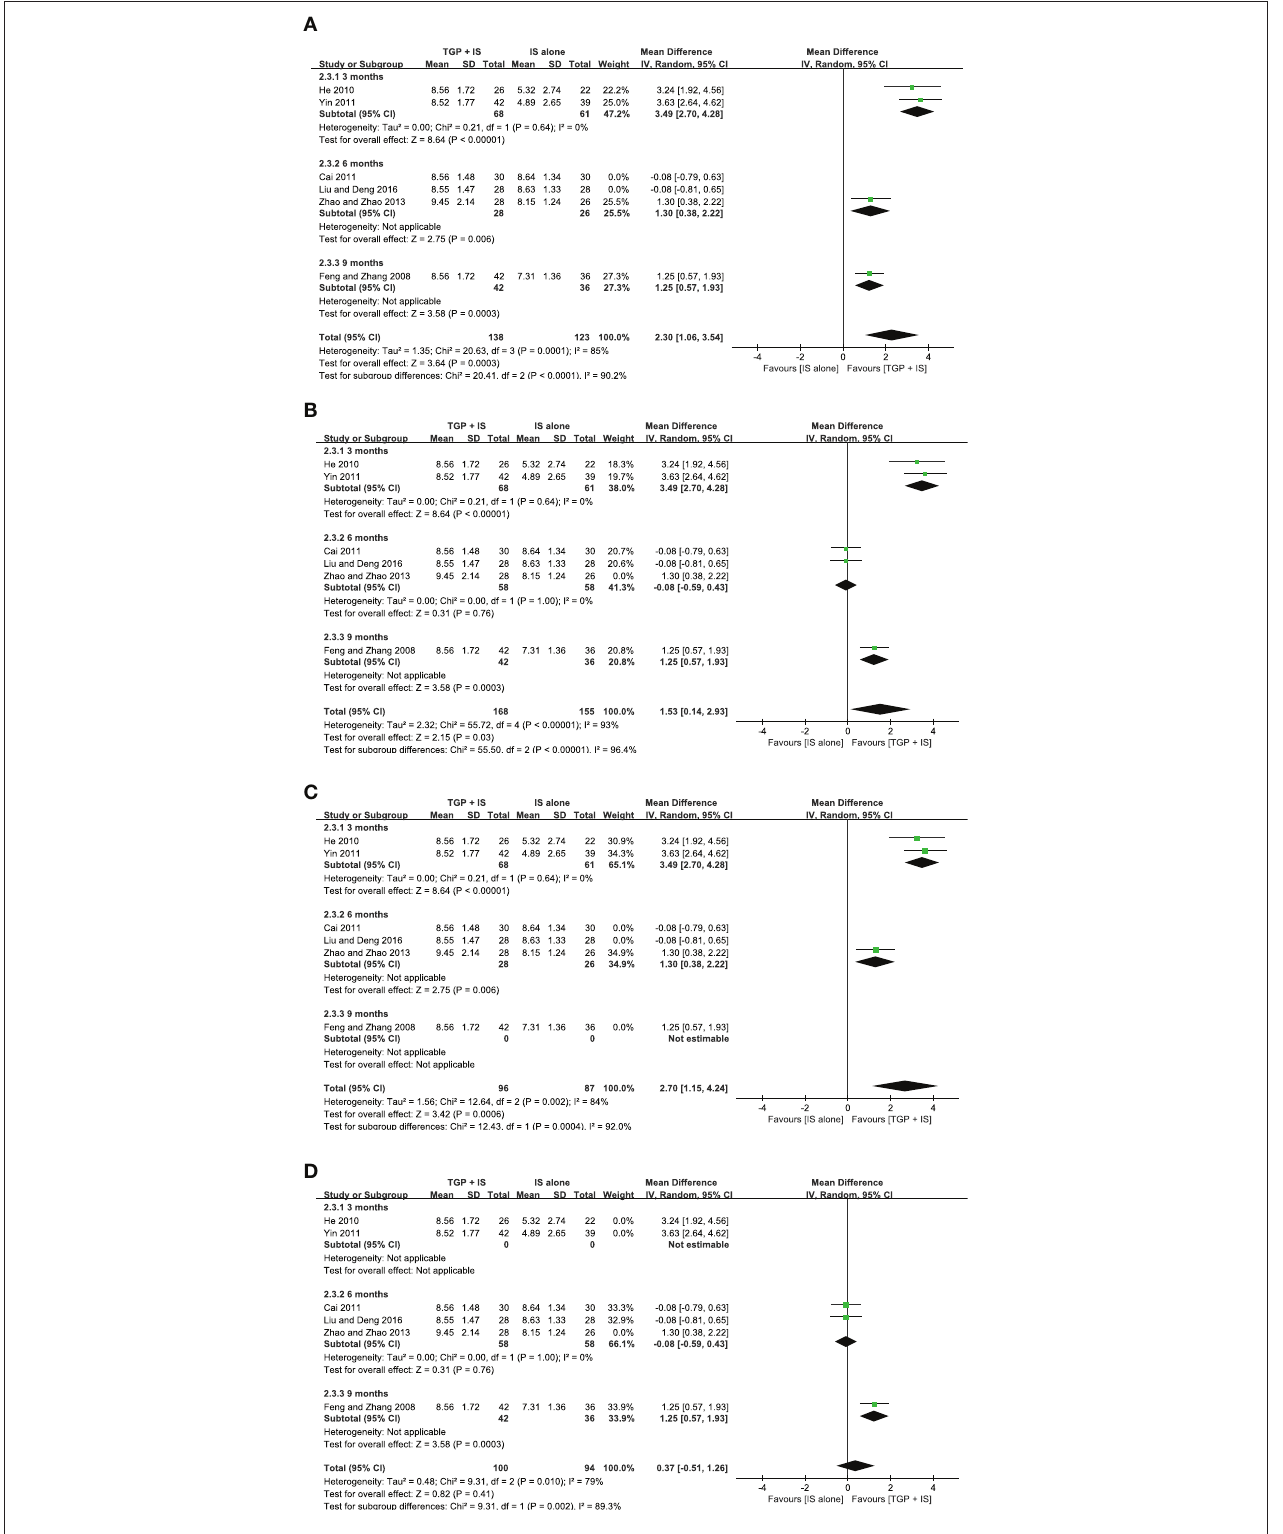
FIGURE 9 | (A–D) Schirmer’s test based on different intervention time (sensitivity analysis).